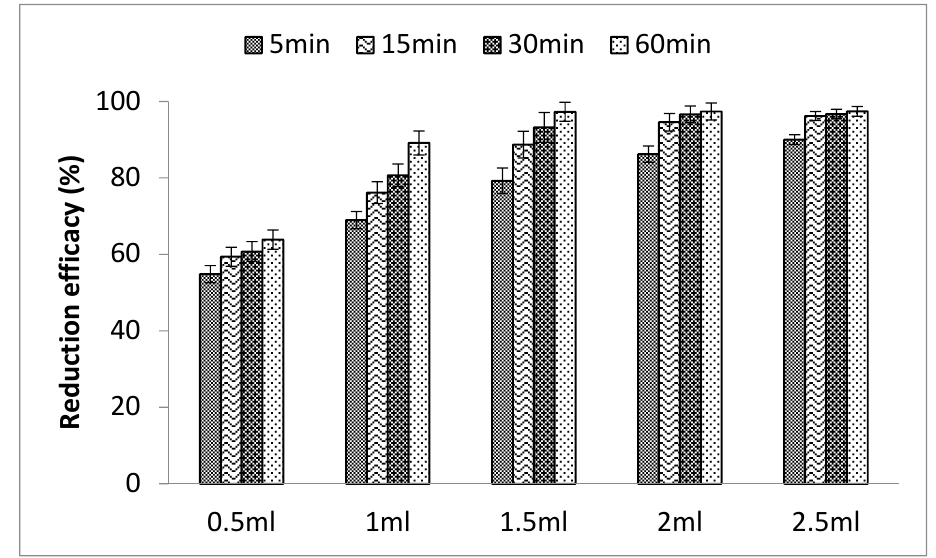
Figure 3. Effects of PLE quantity: [Cr(VI)] 0 = 10 mg·L − 1 , Cr(VI) volume = 25 mL, contact time = 60 min, pH = 2, PLE quantity = 0.5–2.5 mL.